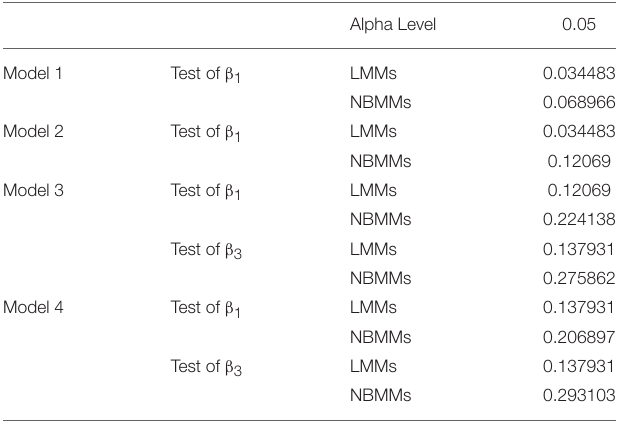
TABLE 3 | Significant taxa rates detected in four models with LMMs and